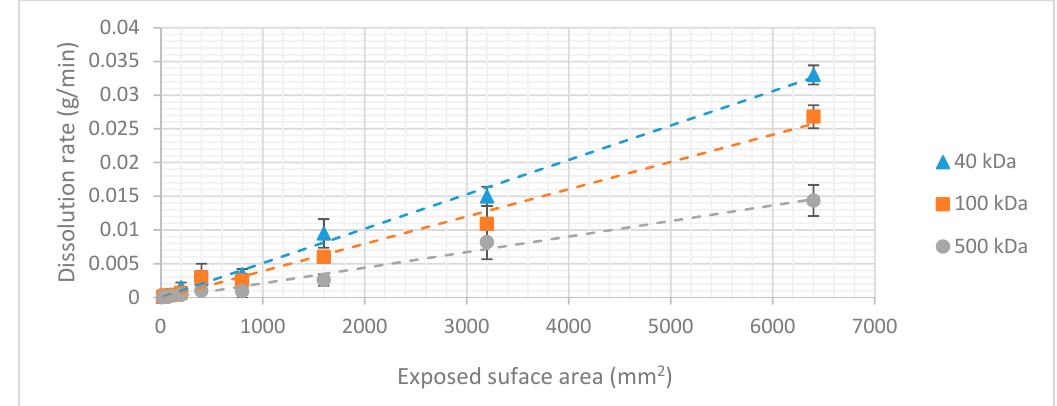
Figure 6. Dissolution rate in function of surface area exposed to the dissolution medium. The error bars represent the standard deviation ( n = 3).